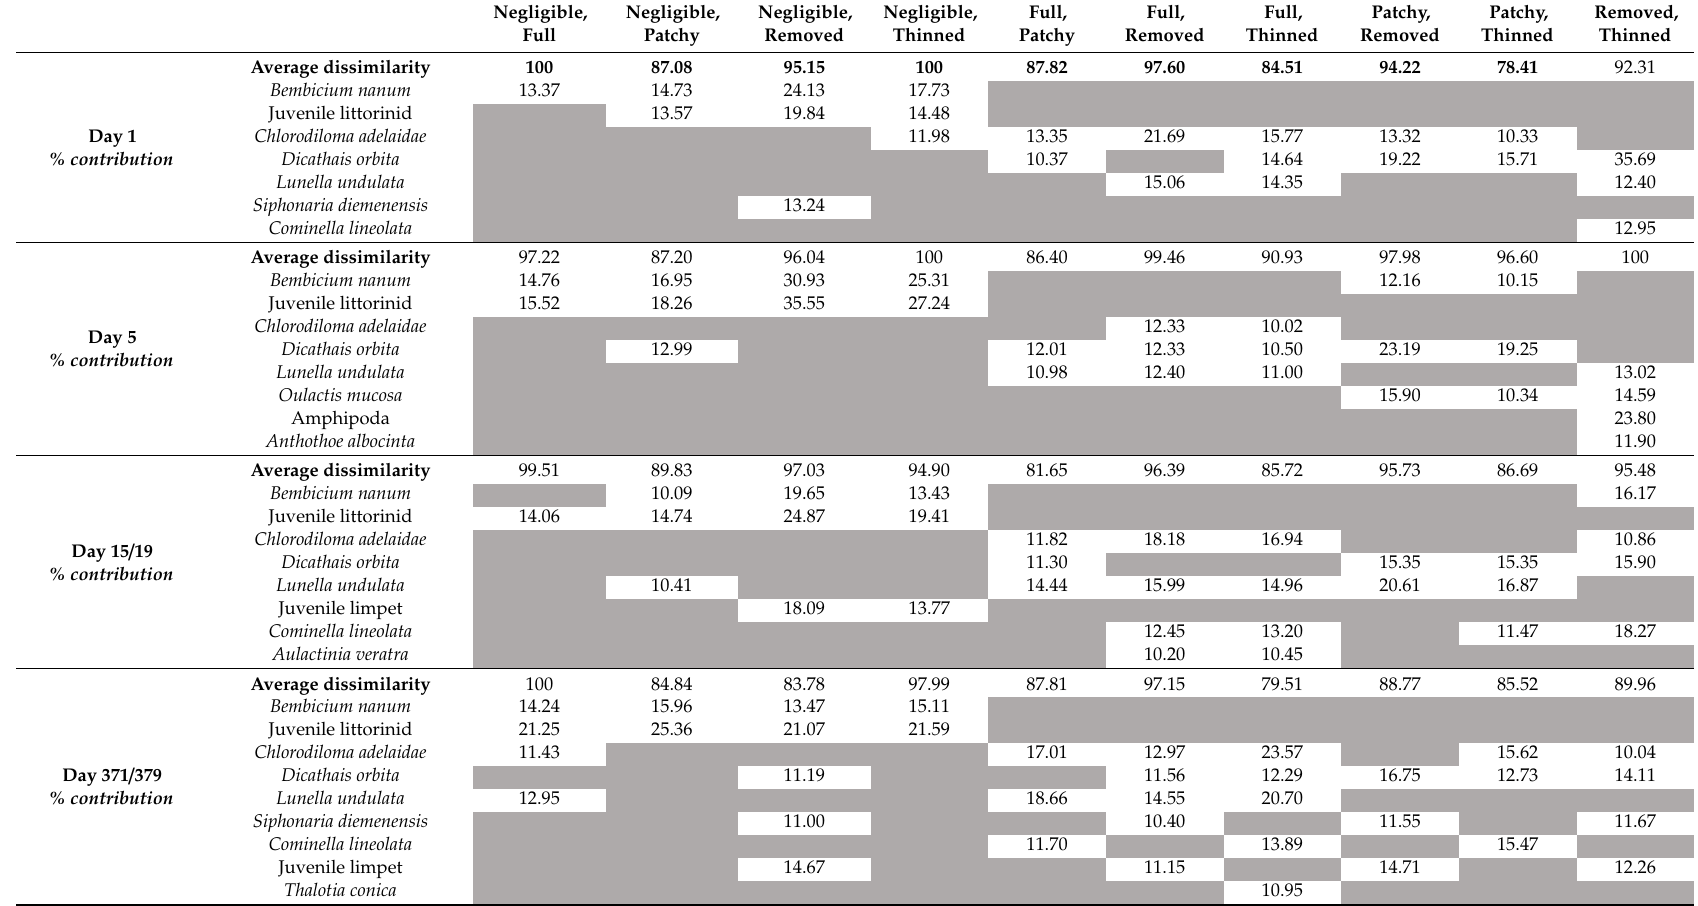
Table A3. Summary SIMPER table: Average dissimilarity of treatment pairs for mobile macroinvertebrates combining Bridgewater Bay and 13th Beach. Contributions > 10% given by